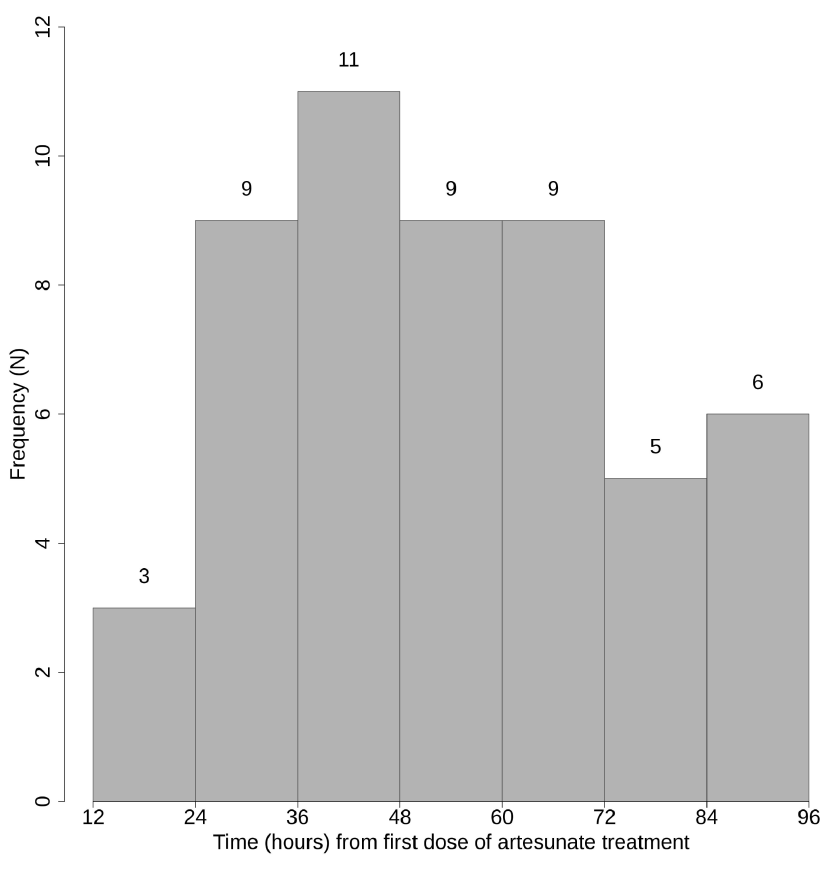
Figure 4. Frequency distribution of parasite clearance time.